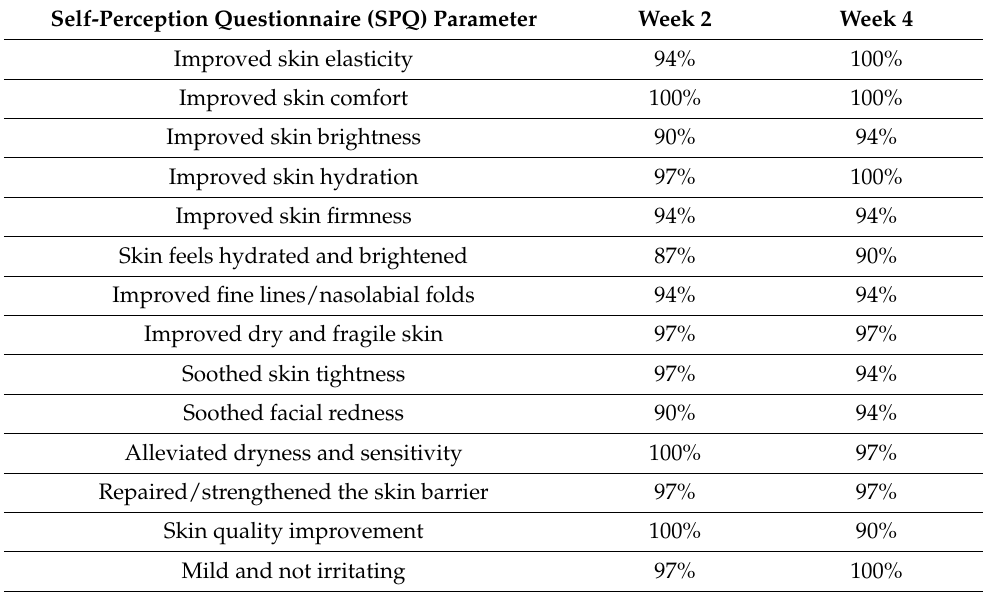
Table 6. Summary of SPQ endpoints for subjects applying 2% E-AGSE